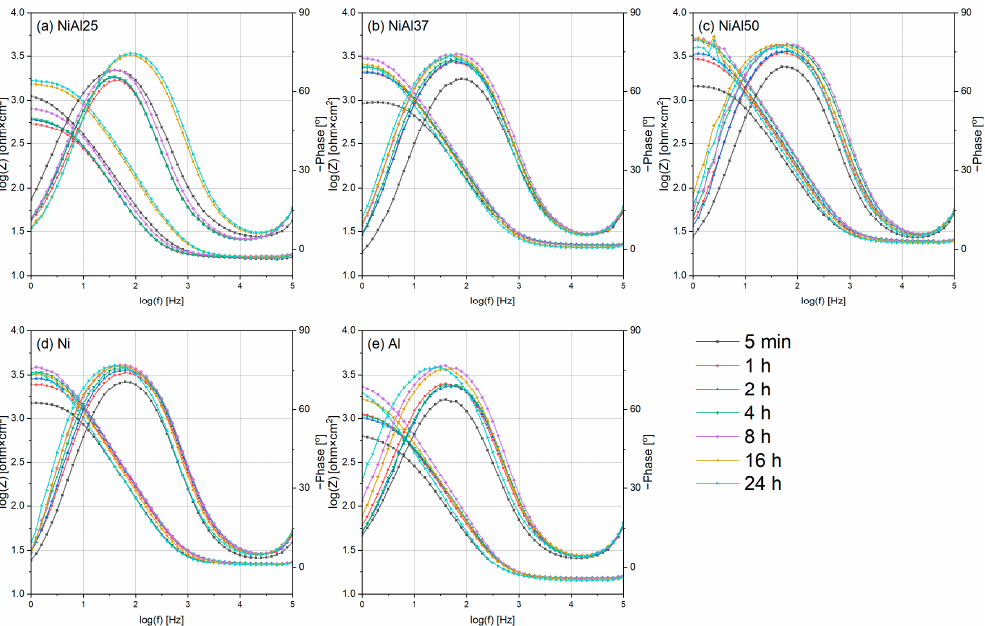
Figure 11. Bode representation of impedance data obtained in 0.1 M H 2 SO 4 , ( a ) NiAl25, ( b ) NiAl37, ( c ) NiAl50, ( d ) Ni and ( e ) Al.